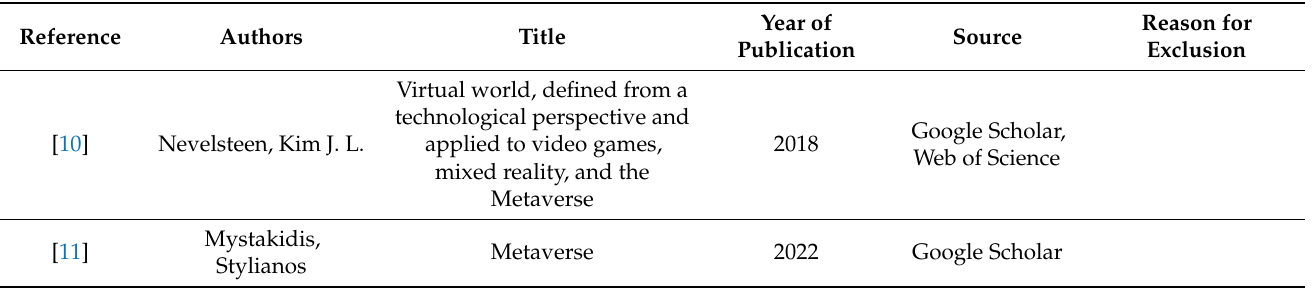
Table 1. List of publications initially included in the qualitative meta-synthesis. For Google Scholar the sequence reflects the respective search result